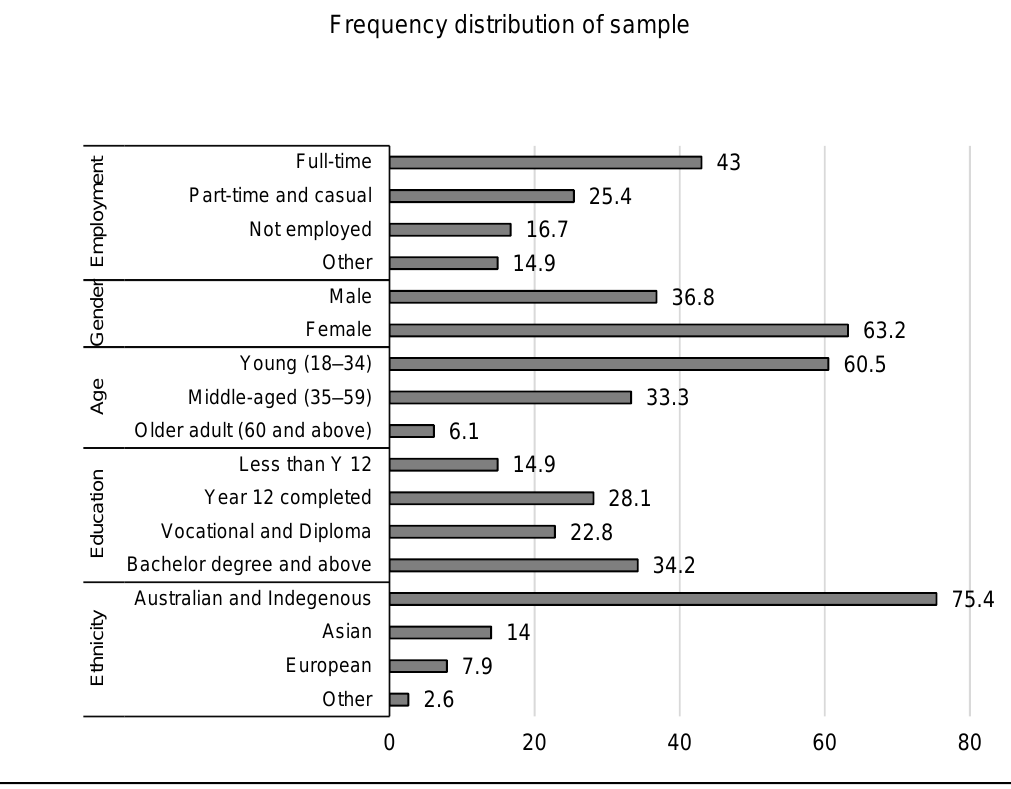
Figure 2. Characteristics of the respondents: Gender, age, education, ethnicity, and employment.